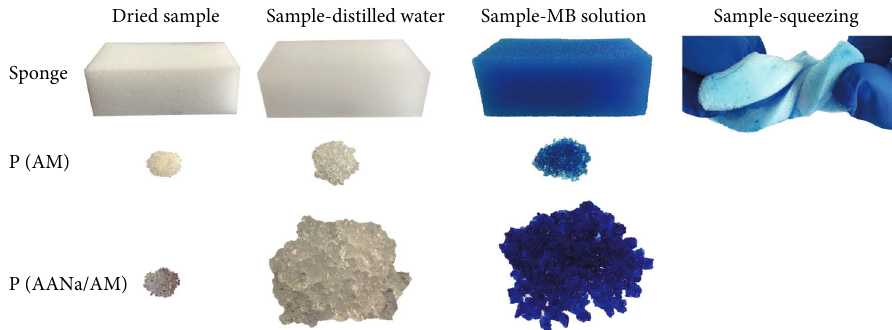
Figure 2: Macromorphologies of sponge, P(AM), and P(AANa/AM) immersed in distilled water and 20 mg/L MB solution.